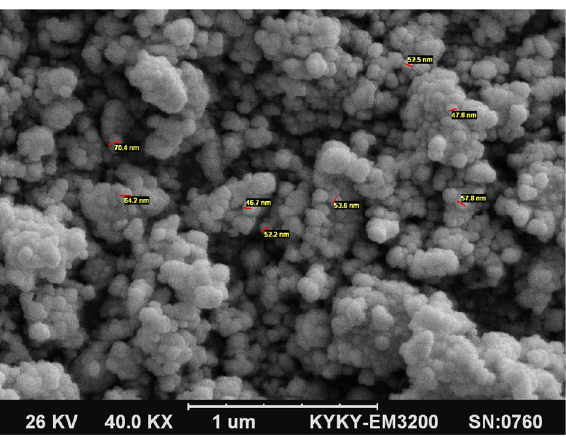
Figure 2. Scanning electron microscope (SEM) image of the MgO nanoparticles.